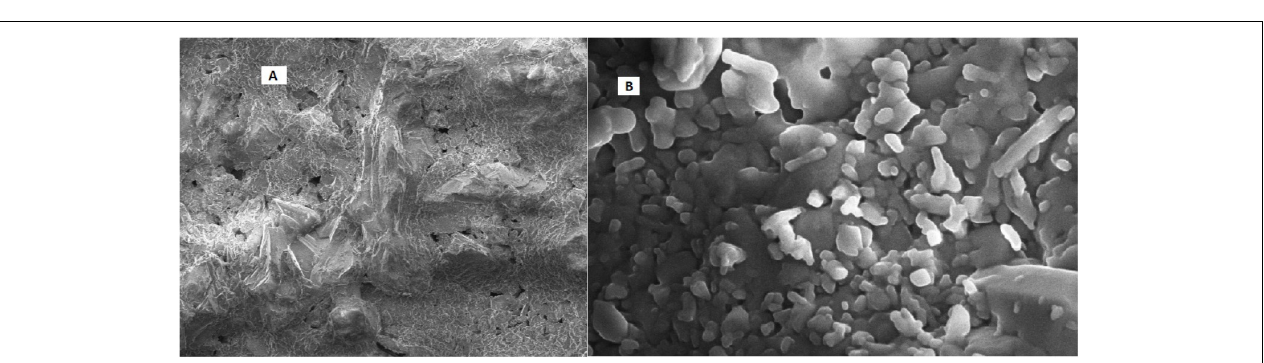
FIGURE 9 | Graphic representation between differential pressure and permeability across the core.